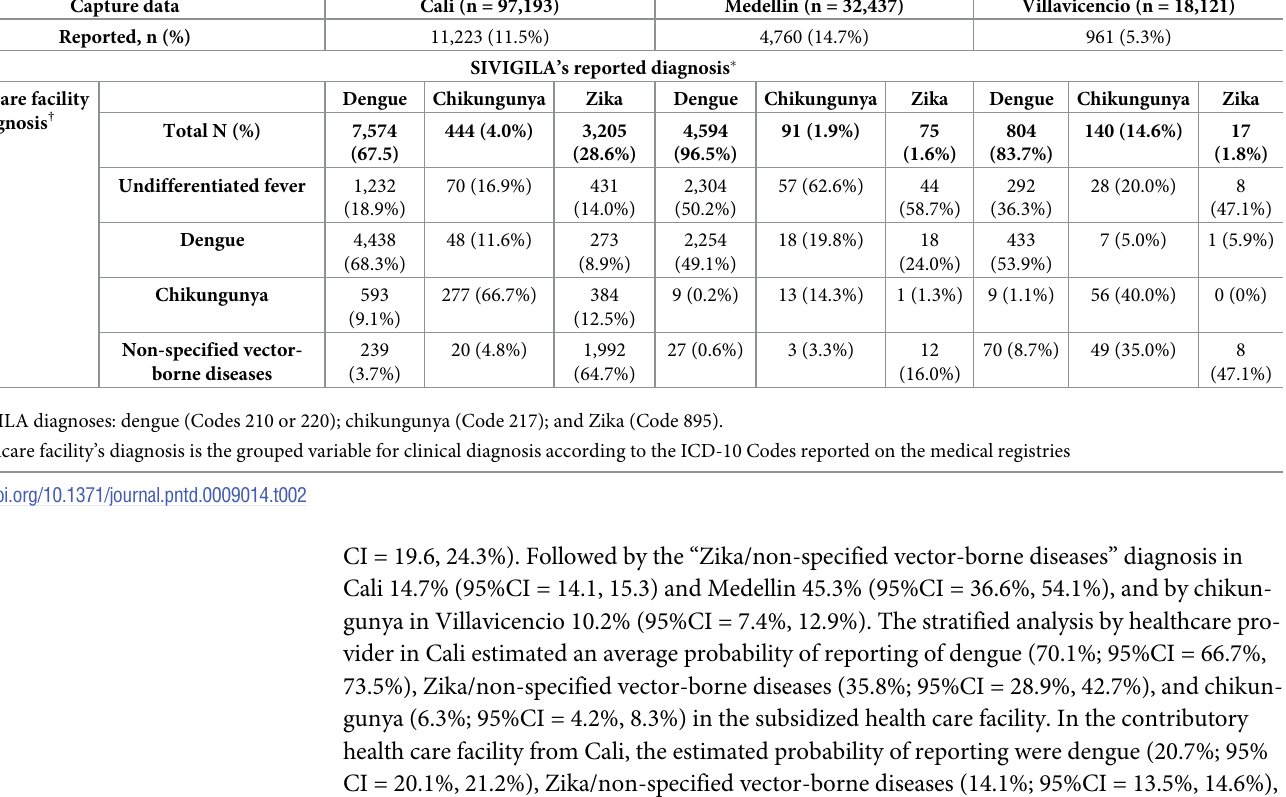
Table 2. Agreement between health care facility’s diagnosis and SIVIGILA’s notified diagnosis of arboviral diseases in Cali, Medellin, and Villavicencio (Colombia) 2014–2017. Capture data